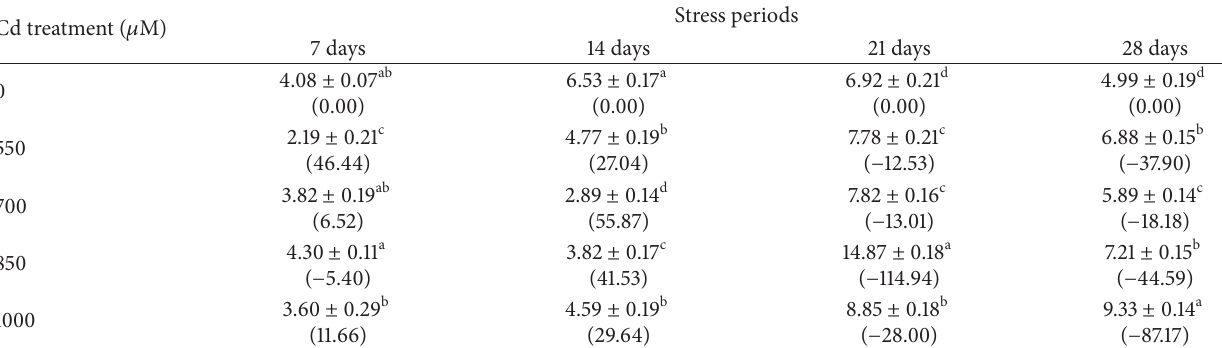
Table 3: Soluble protein (mgg − 1 FW) of cotton callus culture (cv. YZ1) grown under various levels of cadmium. Cd treatment ( 𝜇